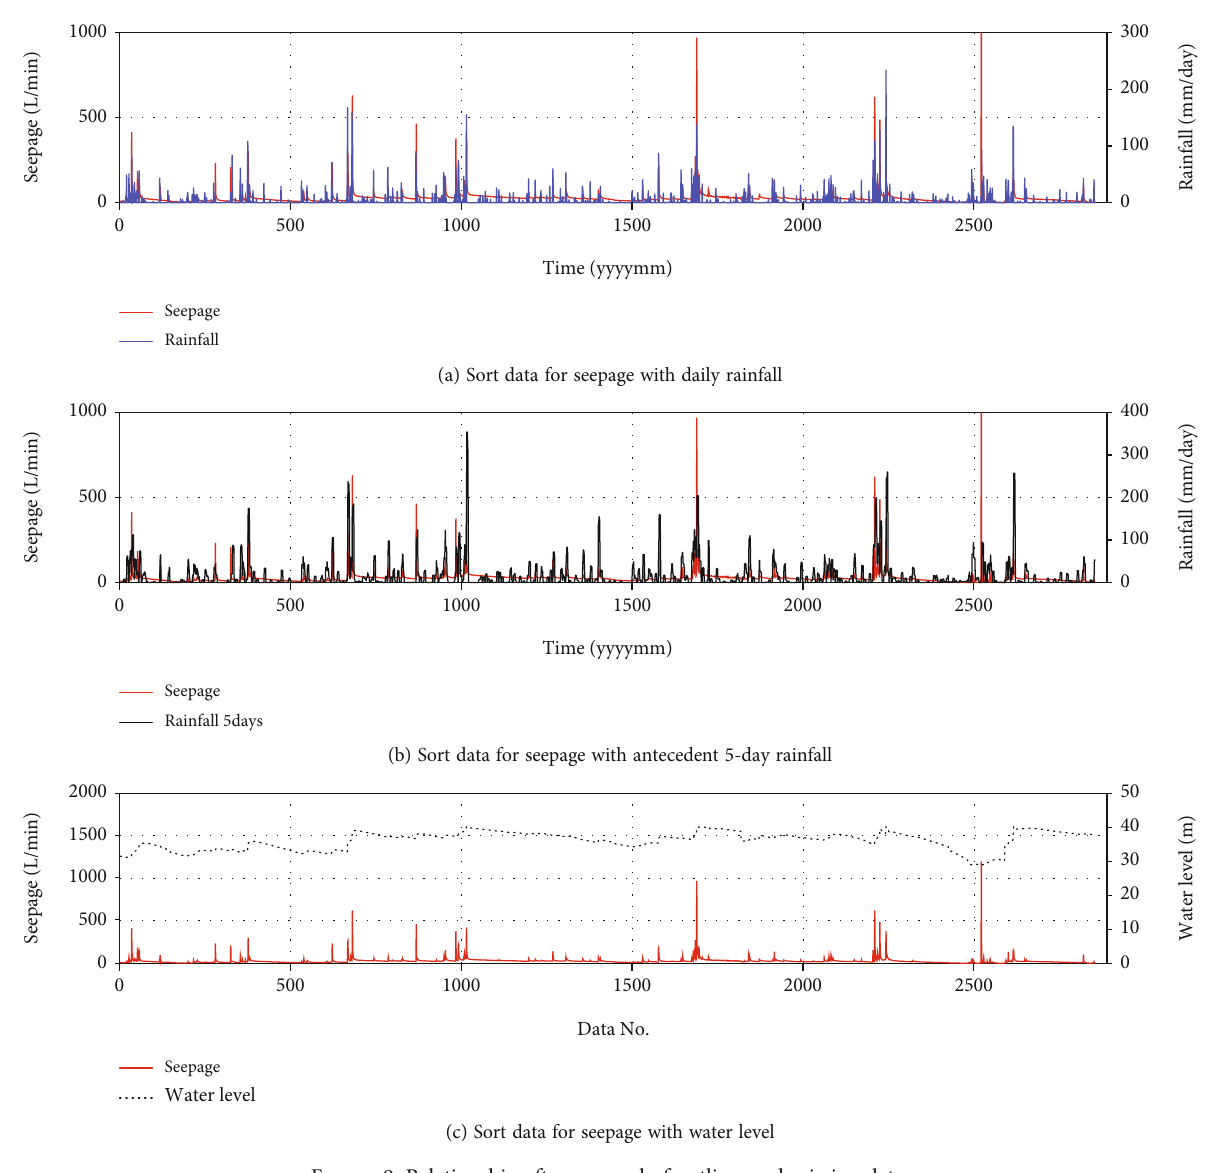
Figure 9: Relationship after removal of outliers and missing data. Table 2: AMC conditions according to antecedent 5-day rainfall